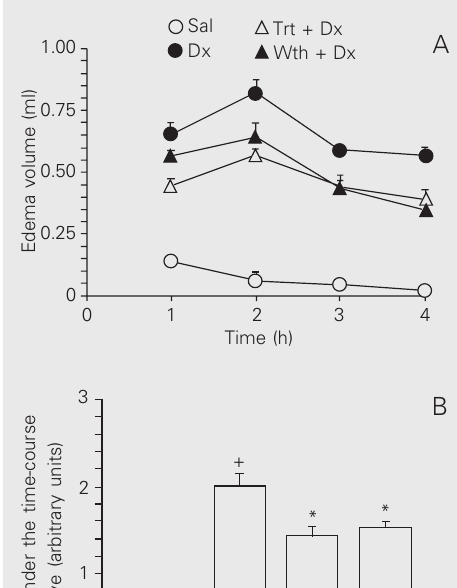
ethanol vapor. The saline